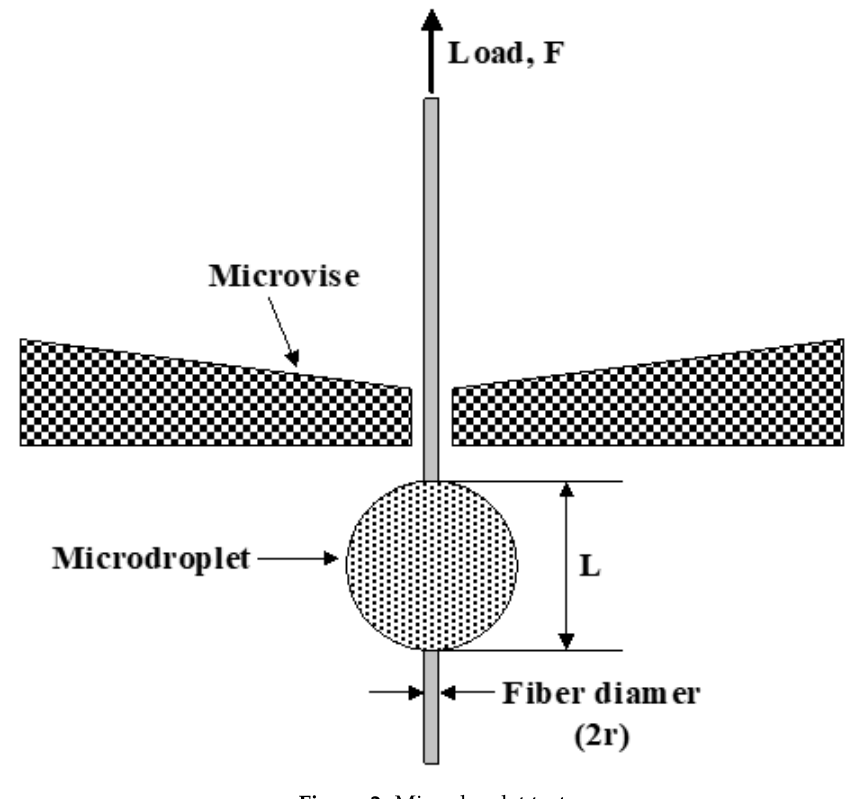
Figure 2. Microdroplet test.